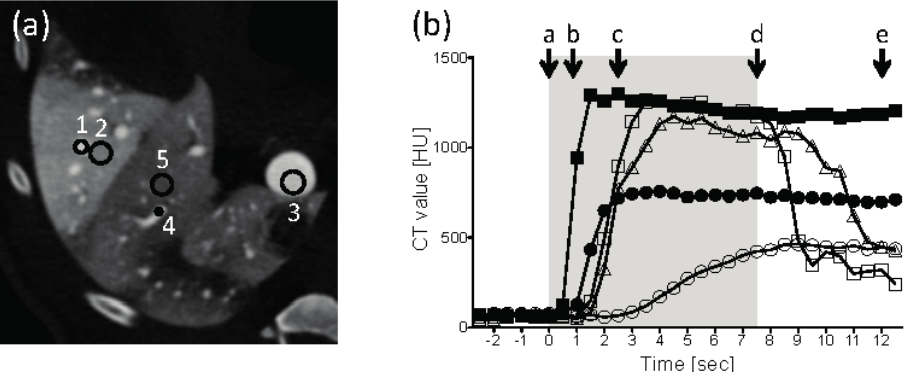
Figure 3. Tissue intensity during a regional hydrodynamic injection. ( a ) The image